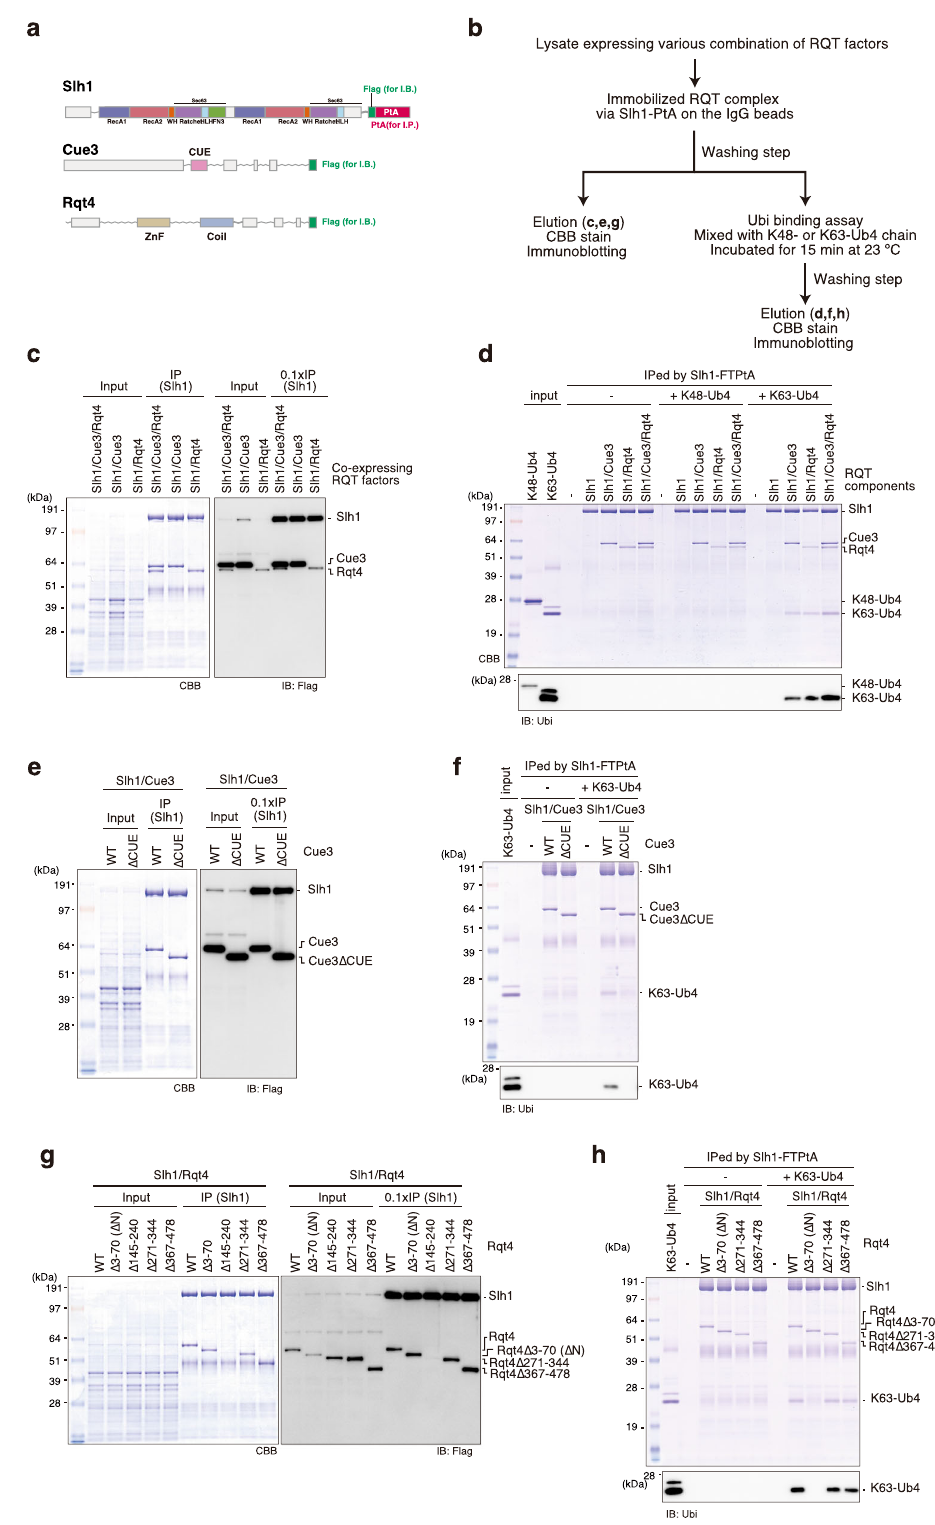
Fig. 2 | TheRQT complex interactswith theK63-linkedubiquitin chainvia two accessory proteins. a Domain structure of each component of the RQT complex. b Schematic of the experiments. c , e , g Puri fi cation of the complex containing the indicated RQT factors. Different combinations of the indicated RQT factors were co-expressed in yeast cells. The complex was af fi nity-puri fi ed via Slh1-Flag-TEV- protein A using IgG magnetic beads. Copuri fi ed RQT factorswere separated by 8% Nu-PAGE and detected by Coomassie brilliant blue (CBB) staining or